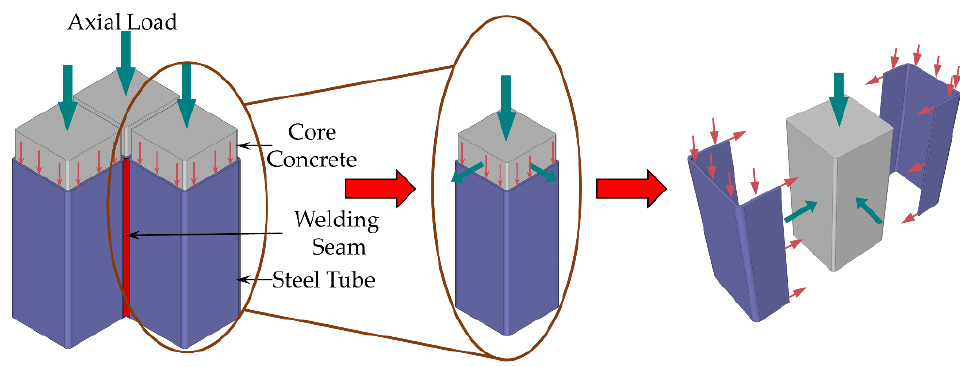
Figure 15. The process of stress changes in steel tubes and concrete.